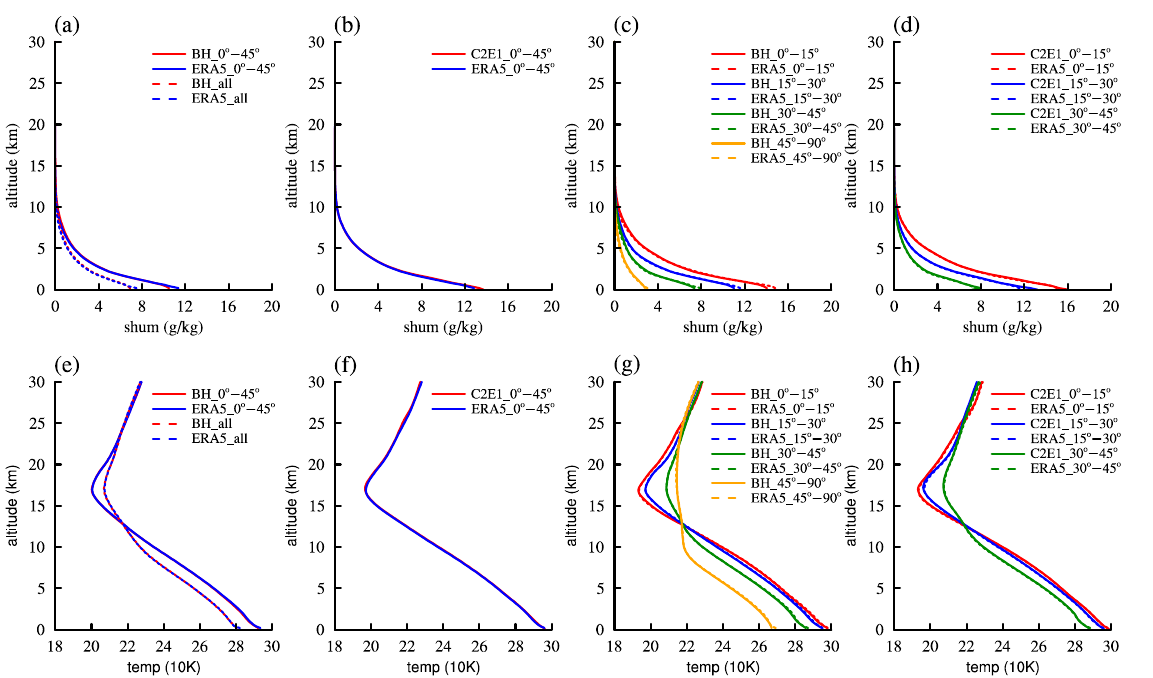
Figure 7. Vertical profiles of the average specific humidity (top; units: g/kg) and temperature (bottom; units: 10 K) for the BH, C2E1, and ERA-5 data at different latitudes. ( a , c ) BH and ERA-5 specific humidity data; ( b , d ) C2E1 (red) and ERA-5 specific humidity data; ( e , g ) BH and ERA-5 temperature data; ( f , h ) C2E1 (red) and ERA-5 temperature data.